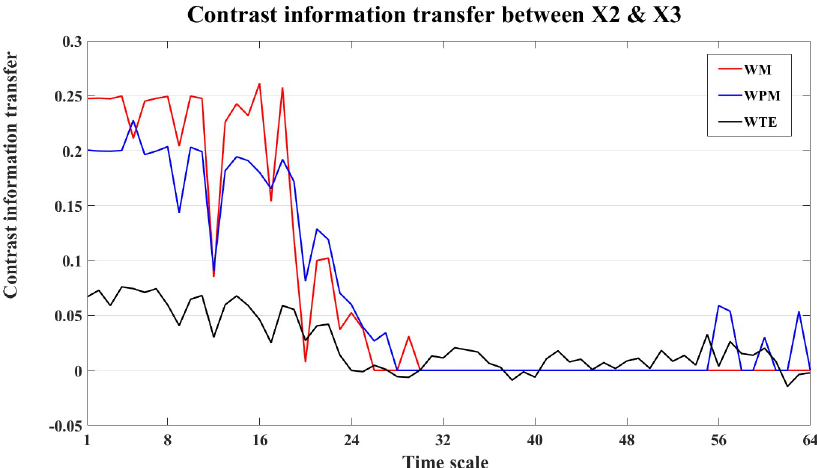
Fig 15. The contrast information transfer values for the linear interaction X2- > X3. The three curves show the contrast WM (red), WPM (blue) and WTE (black) information transfer between X2 and X3 at different time scales s i (i = 1,2, ... 64). All measures indicate X2- > X3 at small time scale s (1 � i < 30), and contrast values decline to zero at i middle time scales. The contrast WM keeps zero at all larger scales, while the contrast WPM rises positive again at some large time scales. The contrast WTE fluctuates around zero level with more positive than negative values. All three measures are able to indicate the correct linear interaction from X2- > X3.